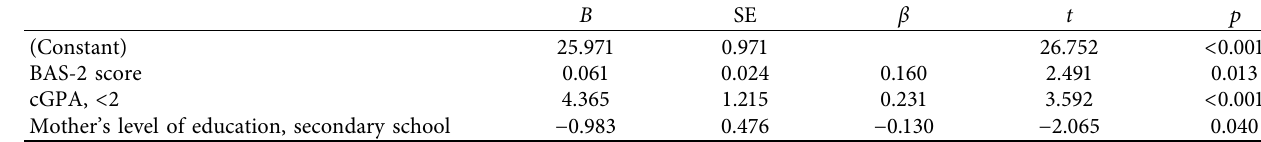
Table 3: Association between self-esteem and sociodemographic factors as well as body appreciation. B